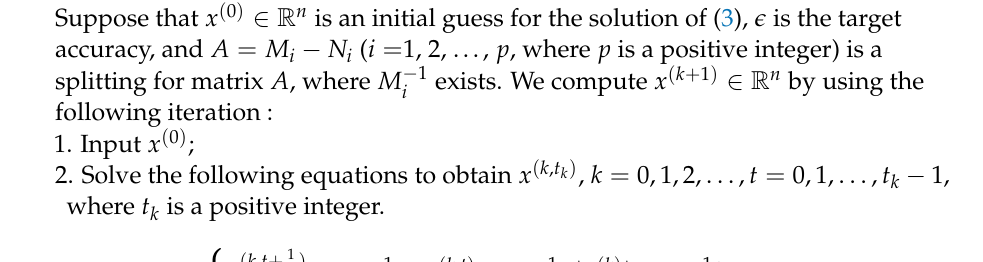
Algorithm 1: Picard Iteration Method (PIM)